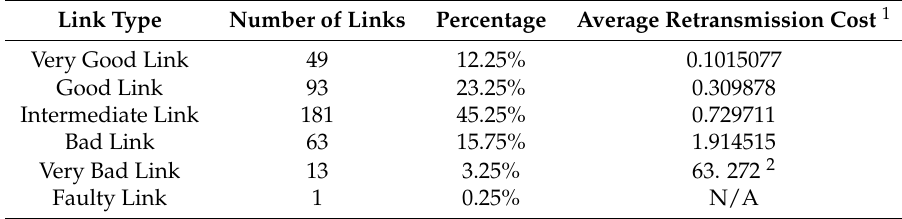
Table 1. Average retransmission